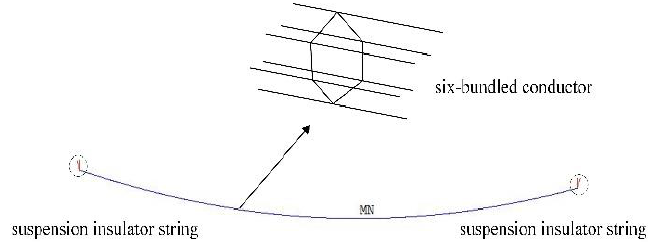
Figure 6. Conductor-insulator string finite element model.